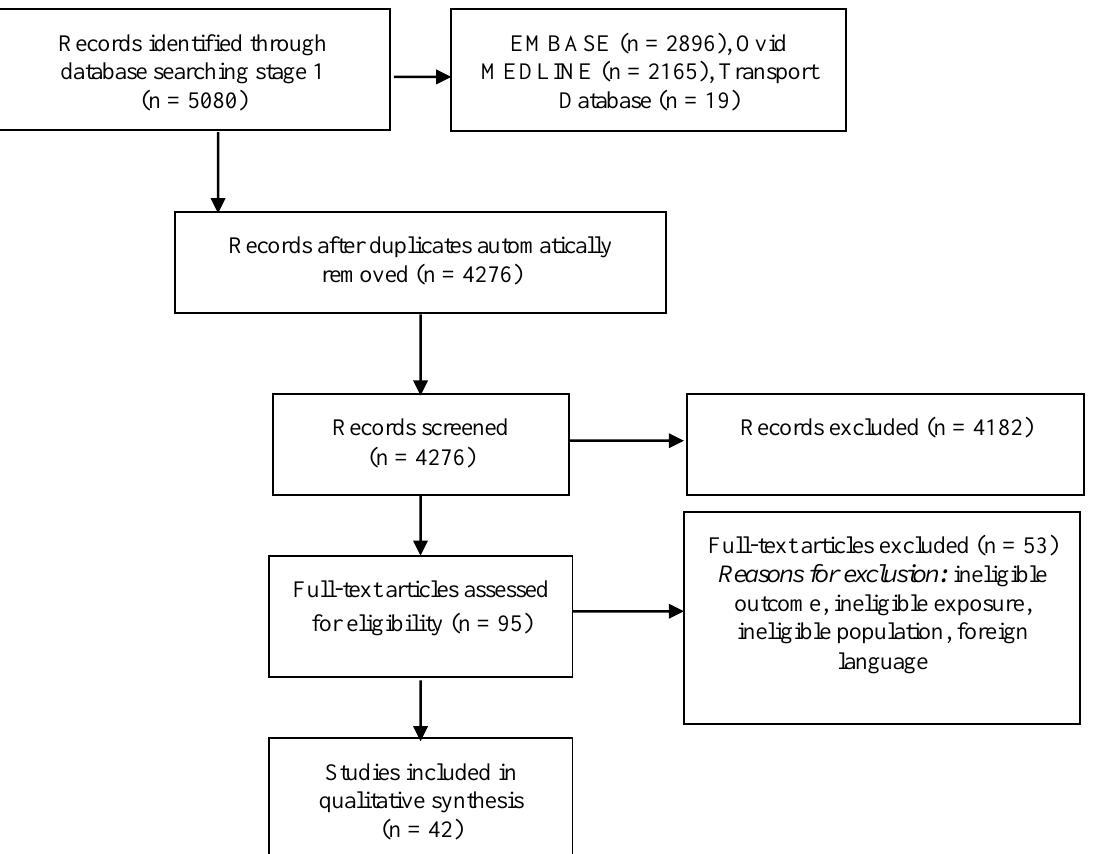
Figure 1. Study screening process.